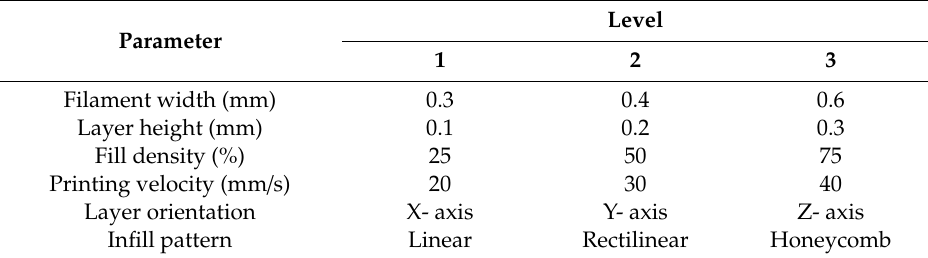
Table 2. Parameters and levels used in design of experiments (DOE).